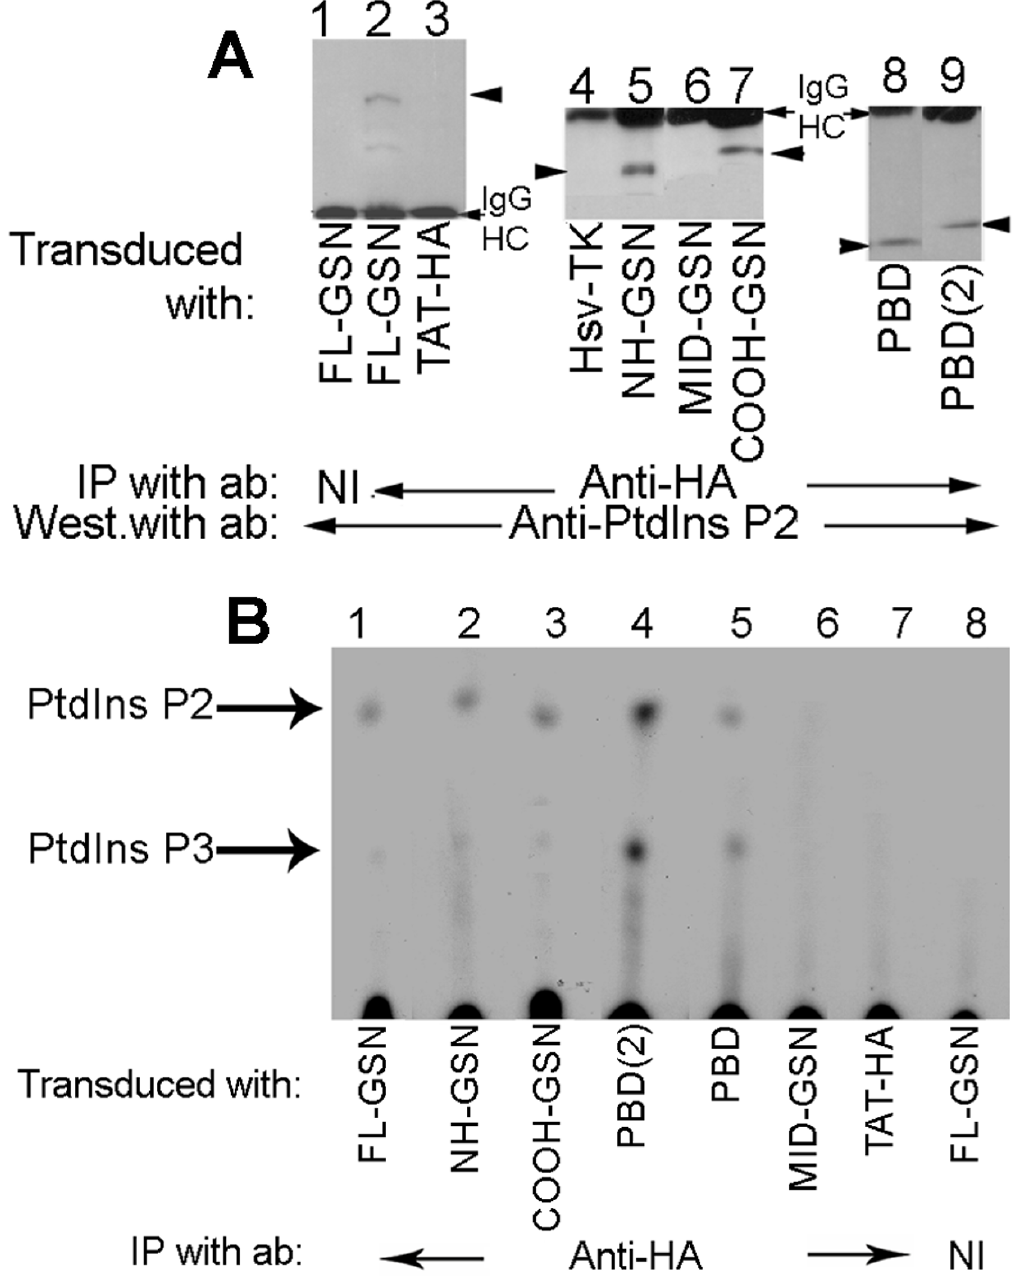
Figure 2 Analysis of PtdIns P association with the transduced protein. Panel A. Western analysis with an anti-PtdIns P2 anti- 2 body: Treatments are as indicated below the figure. Lysates were immunoprecipitated with an antibody to HA (lanes 2–9) or non-immune serum (NI; lane 1). The immunoprecipitates were subjected to 8% SDS-PAGE (lanes 1 to 3) or 15% SDS-PAGE (lanes 4 to 9) and Western analyzed with an antibody to PtdIns P2. PtdIns P2 binding to the transduced peptides is indicated with arrowheads. Arrows indicate IgG heavy chain (IgG HC). The results shown are representative of three independent experiments. Panel B. TLC analysis of the phospholipids associated with the anti-HA immunoprecipitates: 32 P-labeled osteo- clasts were subjected to various treatments as indicated in the figure. Osteoclast lysates made from these cells were subjected to immunoprecipitation with an antibody to HA. 32 P-labeled phosphoinositides associated with anti-HA immunoprecipitates were analyzed by TLC. Arrows on the left side of the figure indicate the migration of PtdIns P2 and PtdIns P3. The results shown are representative of three independent osteoclast preparations and